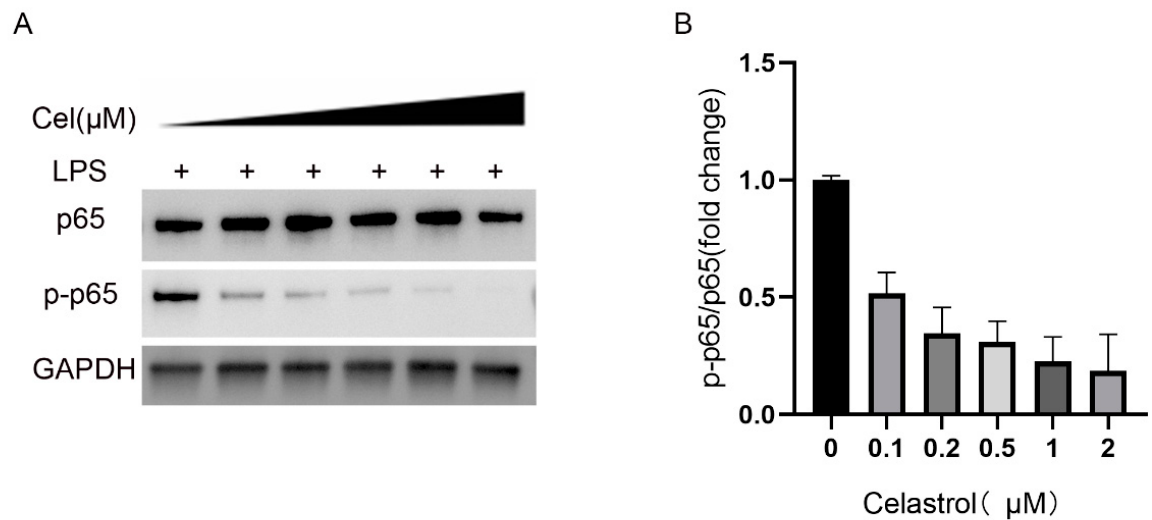
Figure 5. Treatment of ARPE-19 cell line with different concentrations of celastrol. ( A ) Protein level of p65 and p-p65 with celastrol treatment. ( B ) Fold change level of p-p65/p65 after celastrol stimu- lation.